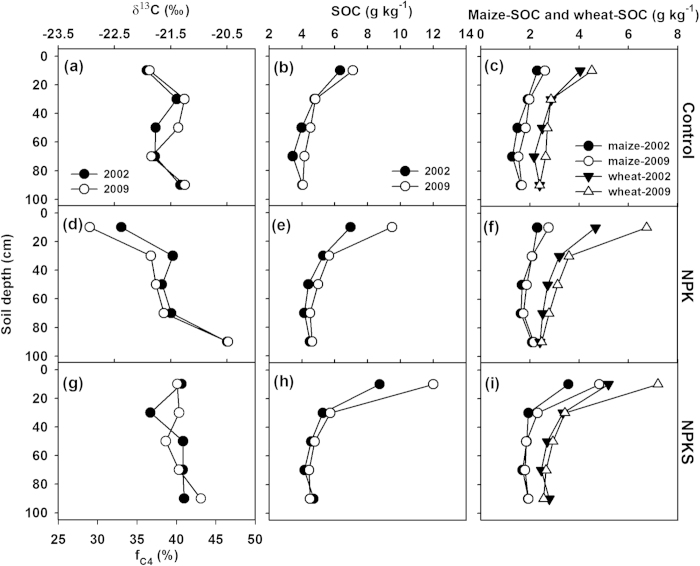
Vertical distributions of δ13C in SOC, fraction of maize derived SOC (fC4) (left column), total SOC (middle column), maize and wheat derived SOC (right column) under control (top row), NPK (middle row) and NPKS (bottom row) at Yangling.